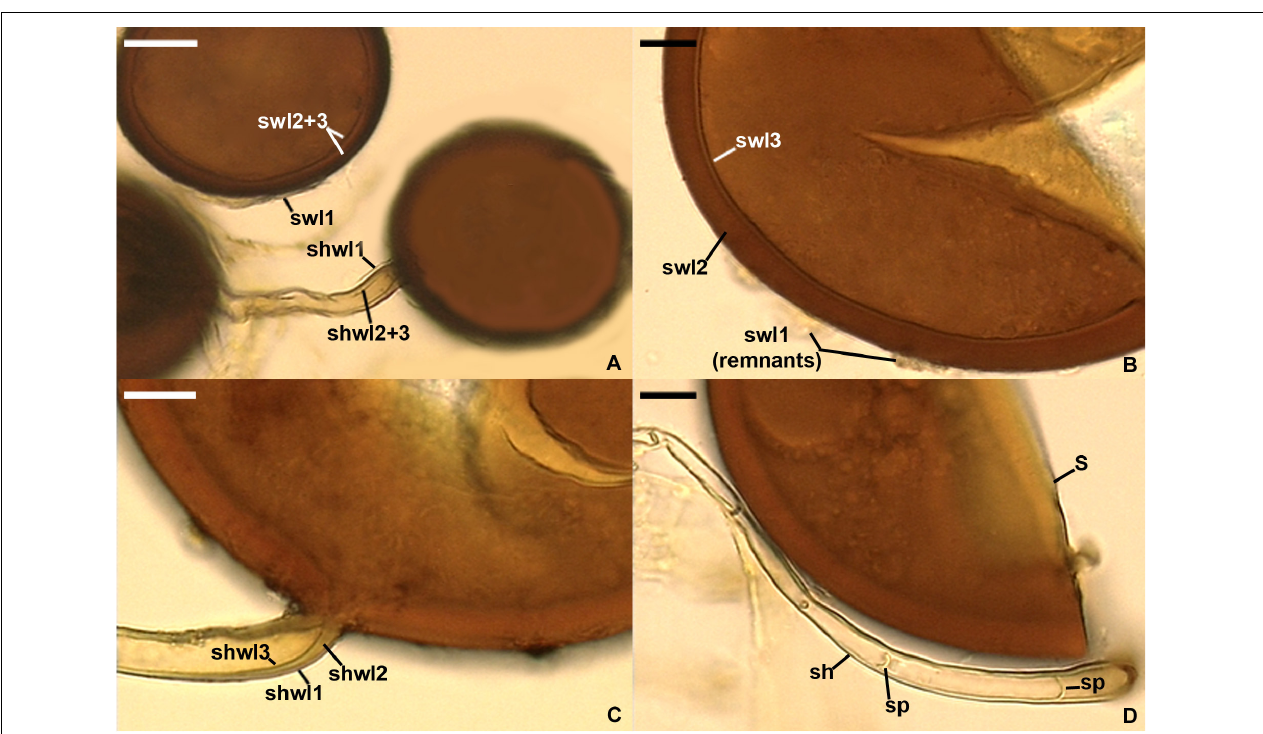
FIGURE 6 | Silvaspora neocaledonica . (A) Spores with a spore wall (sw) consisting of three layers (swl1–3). (B) Spore wall layers (swl) 1–3; swl1 is almost completely sloughed off. (C) Subtending hyphal wall layers (shwl) 1–3. (D) Spore (s) and subtending hypha (sh) with two septa (sp) indicated. (A,B,D) Spores in PVLG. (C) Spores in PVLG + Melzer’s reagent. (A–D) Differential interference microscopy. Scale bars: (A) = 20 µ m, (B–D) = 10 µ m.